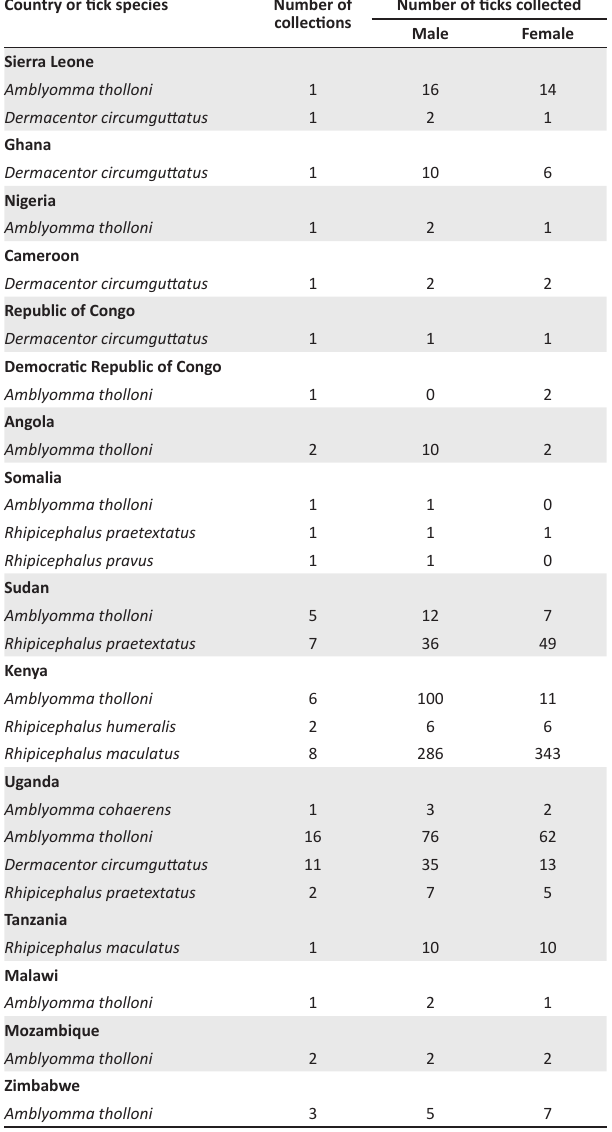
the United States National Tick Collection. Country or tick